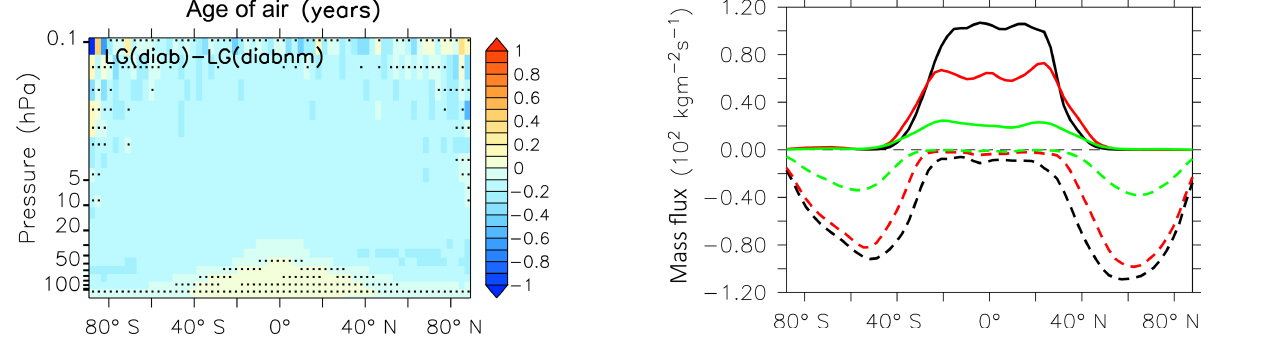
Figure 12. Zonal mean difference between LG(diab) with standard mixing of the SF 6 _AoA tracer and LG(diab) with no mixing (nm) between adjacent parcels. The non-stippled area is statistically sig- nificant to the 99% level.